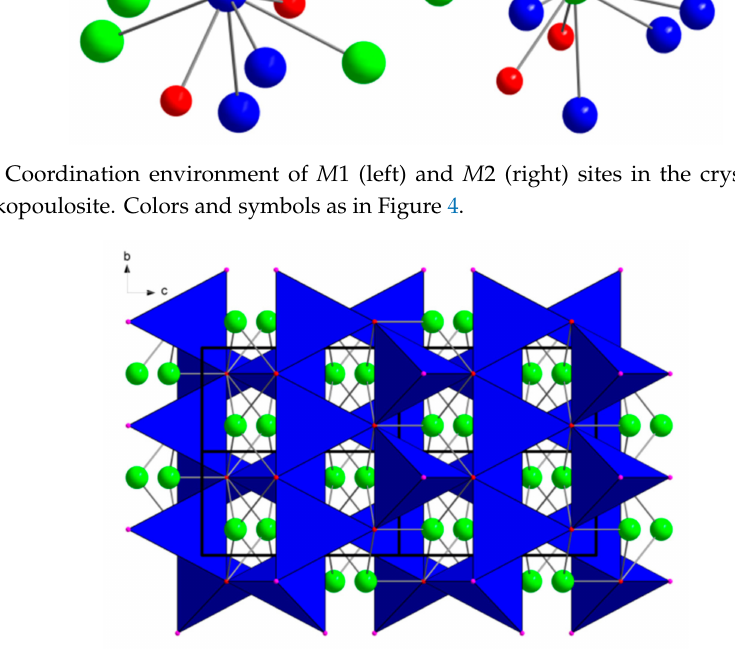
Figure 6. Polyhedral representation of the M 1P 4 tetrahedra in the crystal structure of grammatikopoulosite. Colors and symbols as in Figure